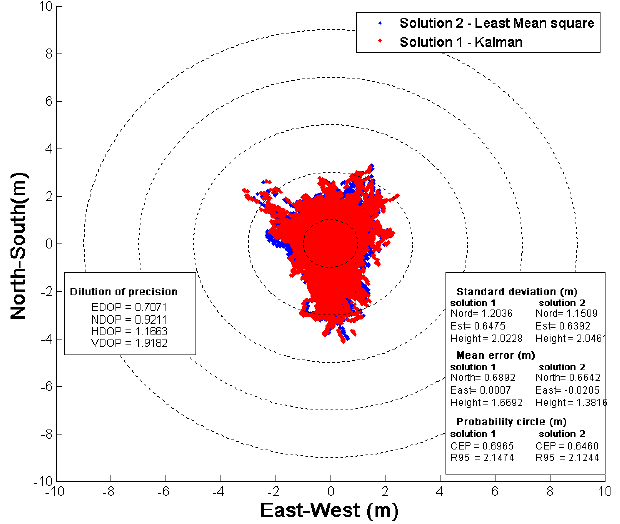
Figure 12. Different Correlator Spacing (Through Different Signals) Impact on DLL Noise vs. C { N 0 .